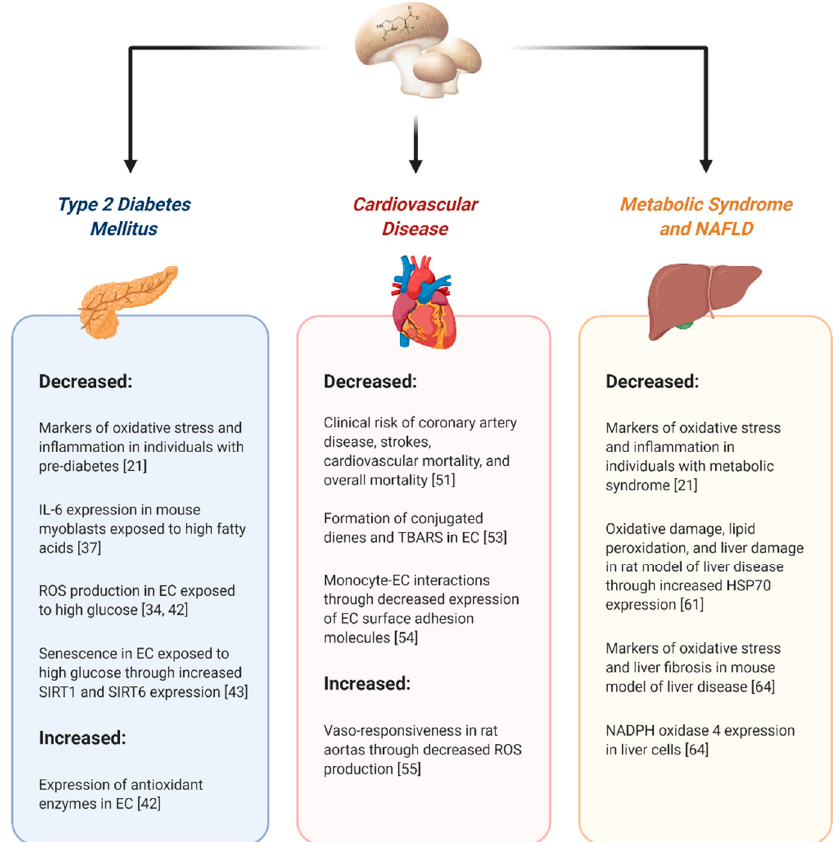
Figure 1. Potential cardiometabolic benefits of ergothioneine (EGT) consumption, supplementation, or